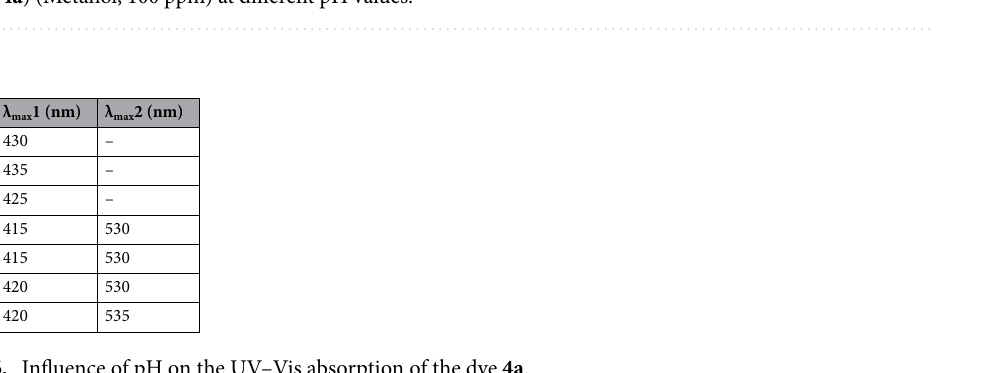
Figure 8. Spectral changes of the 5-(phenyl)-5H-spiro[diindeno[1,2- b :2 ′ ,1 ′ - e ]pyridine-11,3 ′ -indoline]-2 ′ ,10,12- trione ( 4a ) (Metanol, 100 ppm) at different pH values.